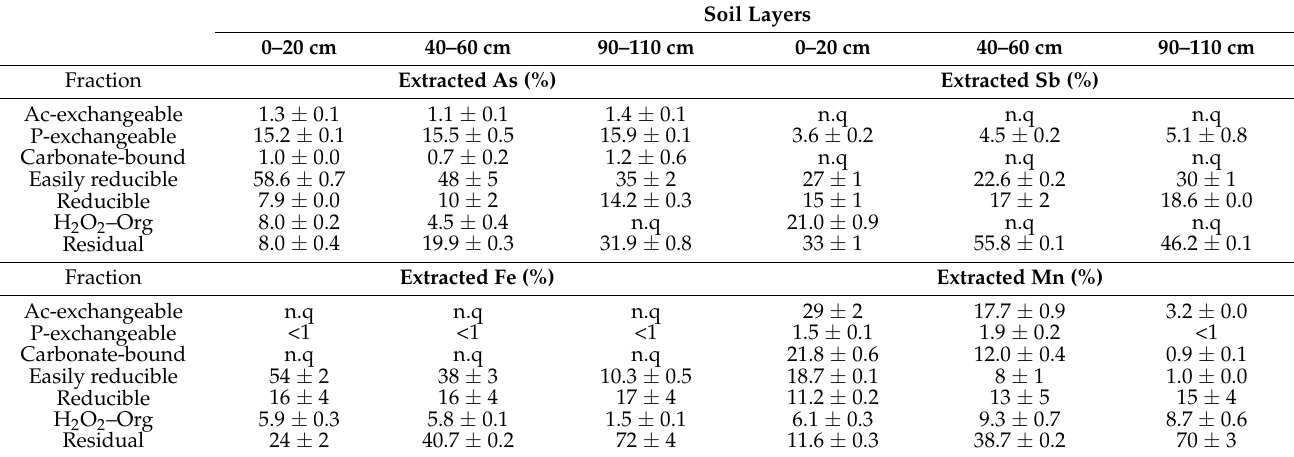
Table 2. Percentages (%) of extracted As, Sb, Fe and Mn relative to the element amounts measured in each fraction out of the sum of all the fractions. n.q: non